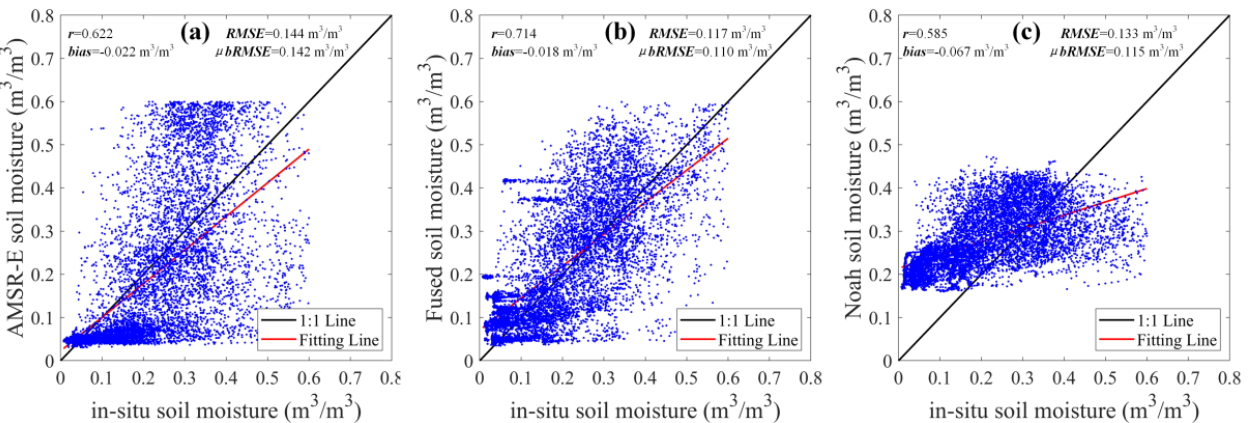
Figure 7. Scatter plots between in situ soil moisture and AMSR-E ( a ), fused MODIS ( b ), and Noah surface soil moisture ( c ).